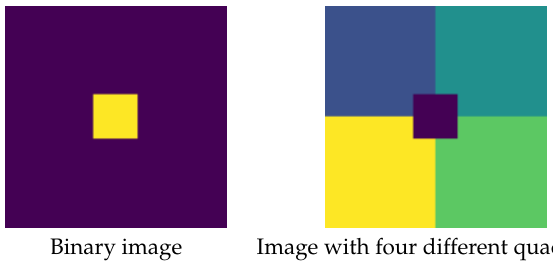
Figure 6. Synthetic 100 × 100 images used for the tests. The image on the left has value 1 on the inner 20 × 20 square and 0 outside, the image on the right has values from 1 to 4 clockwise starting from the top left quadrant and 0 in the inner square.